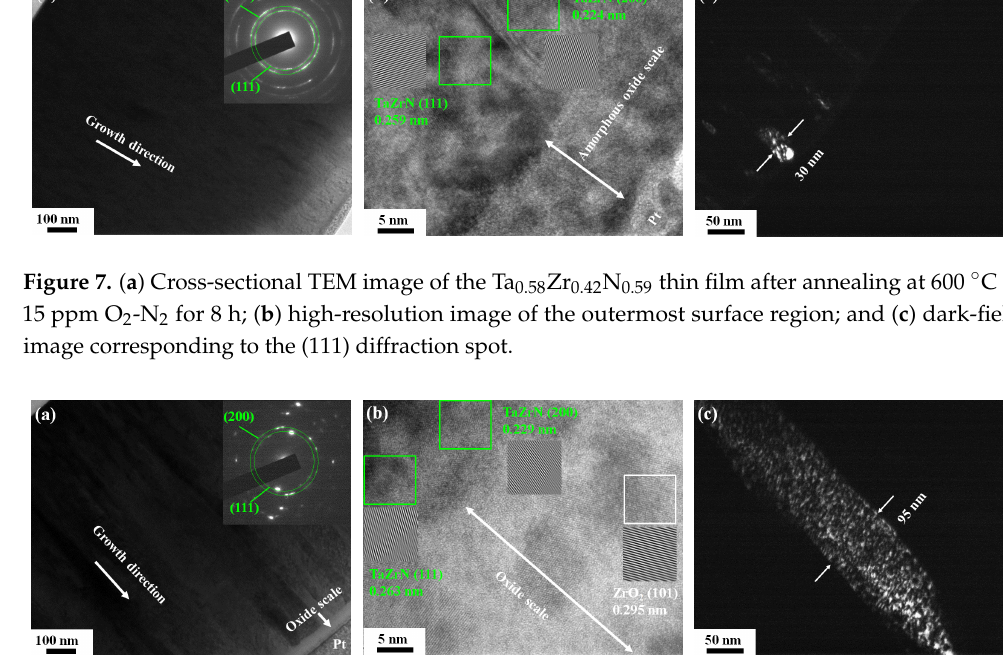
Figure 8. ( a ) Cross ‐ sectional TEM image of the Ta 0.33 Zr 0.67 N 0.68 thin film after annealing at 600 °C in 15 ppm O 2 ‐ N 2 for 8 h; ( b ) high ‐ resolution image of the near ‐ surface region; and ( c ) dark ‐ field image corresponding to the (111) diffraction spot.